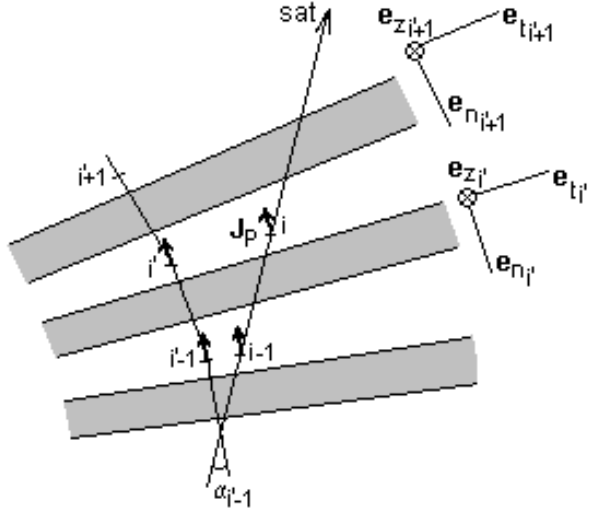
Fig. B2. Set of non-parallel infinite current sheets (schematic pic- ture). Again, the view is from above the ionosphere and α i 0 is the incidence angle of the spacecraft with the current sheet i’ . i 0 − 1 and i 0 are arbitrary points located between different current sheets. i − 1 and i are the corresponding points located along the satellite trajectory. J P denotes the Pedersen current